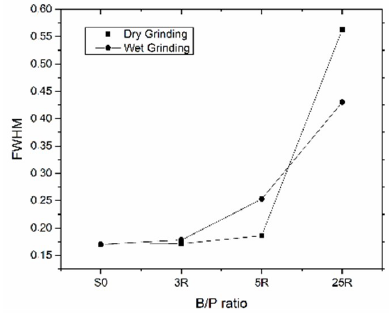
Figure 3. FWHM for kaolinite peaks [001] during dry and wet grinding with different B/P ratio. SEM-SE micrographs of the untreated reference sample (S0) and the most reactive sample (DG-